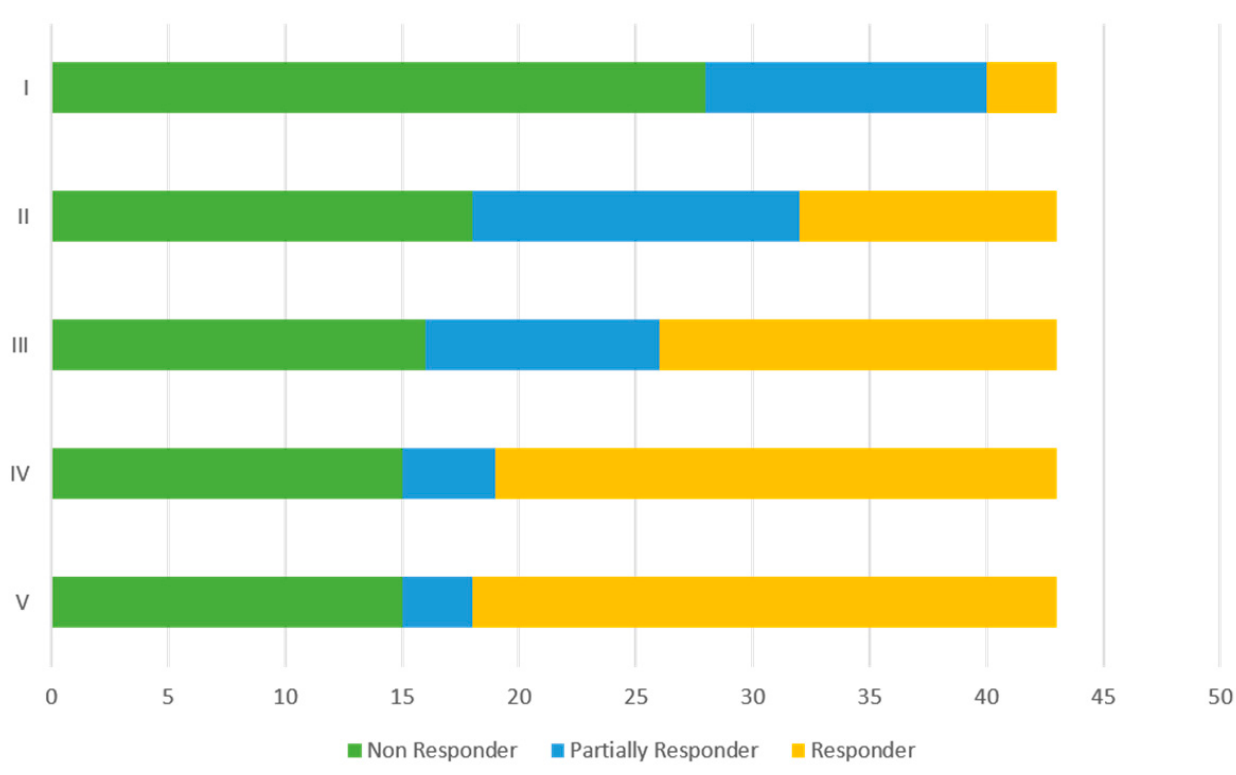
Figure 3. Frequencies of non-responders (NR), partial responders (PR), and good responders (GR) at each OBT-A cycle.